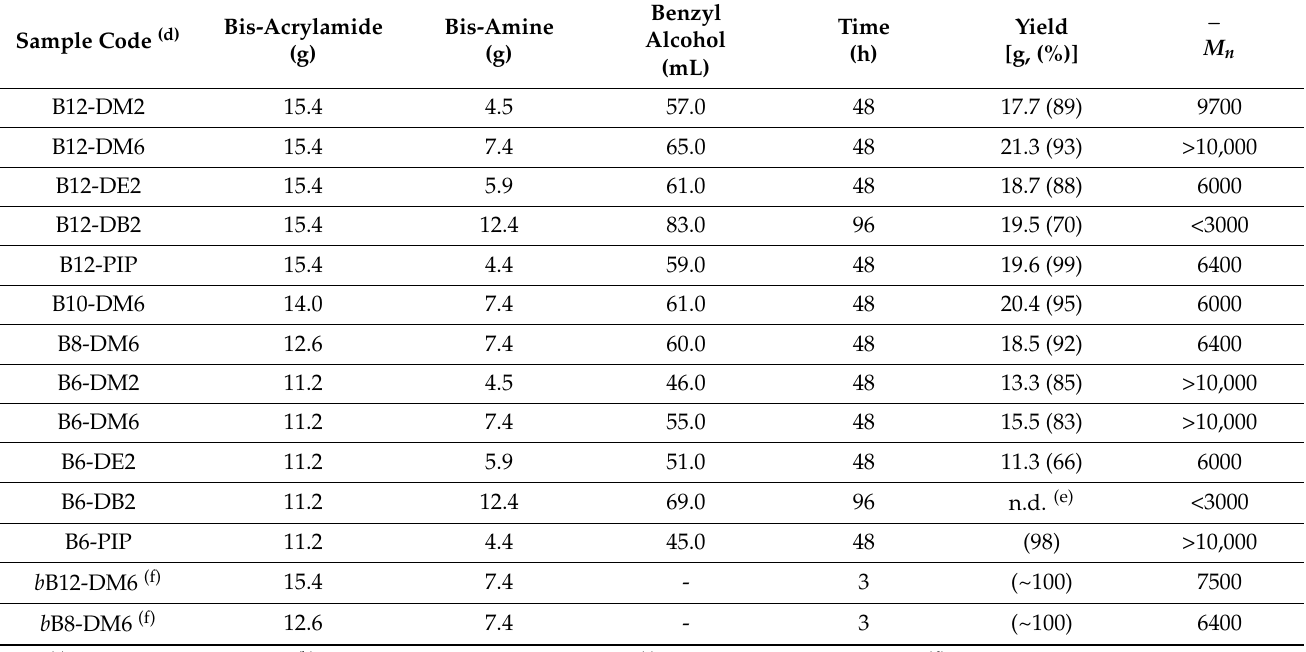
Table 2. Amounts of reagents used in the synthesis of H-PAAs by solution (a,b) and bulk processes (b,c) . Sample Code (d) Bis-Acrylamide